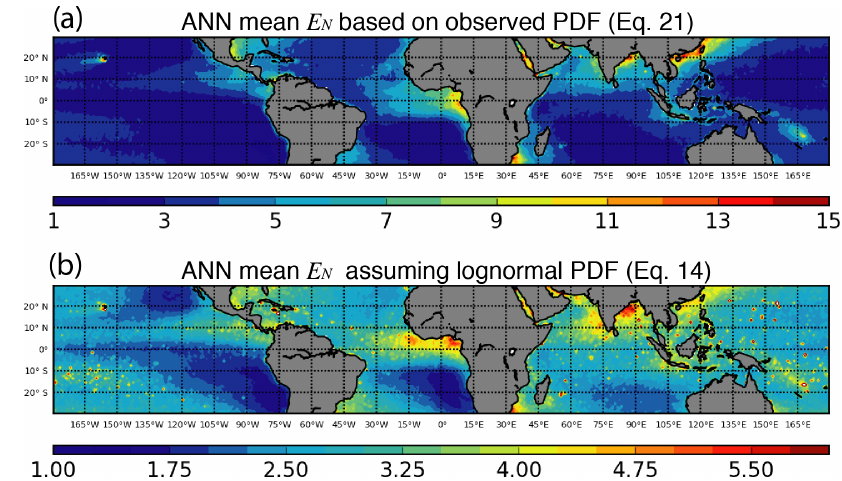
Figure 9. Annual mean value of the enhancement factor E N derived from (a) observation based on Eq. (21) and (b) from Eq. (14) assuming lognormal subgrid CDNC distribution.